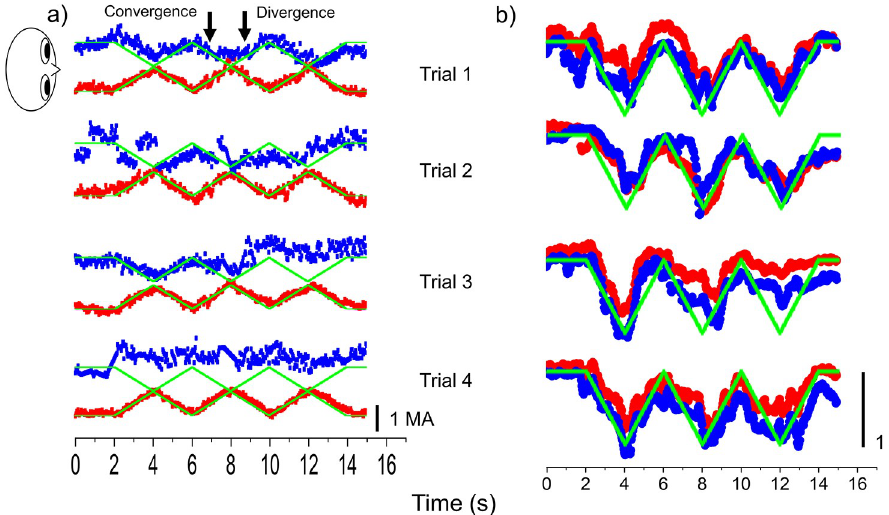
for the postvisual task than for the previsual task (4.7 ± 3.2 cm vs. 5.6 ± 3.8 cm; P = 0.012; Fig 3b, Table 3, and S1 and S2 Tables). Fusional vergence range was not significantly different between the pre- and postvisual task (23.6 ± 8.7 PD vs. 21.1 ± 10.8 PD; P = 0.134; Fig 3c, Table 3, and S1 and S2 Tables). Subjective eye symptom scores (Q1, Q2, and Q3) were signifi- cantly worse in the postvisual task than in the previsual task (Q1, P = 0.003; Q2, P = 0.034; Q3, P = 0.002; Table 3, and S1 and S2 Tables). The quartiles of BFM, NPC, and fusional vergence